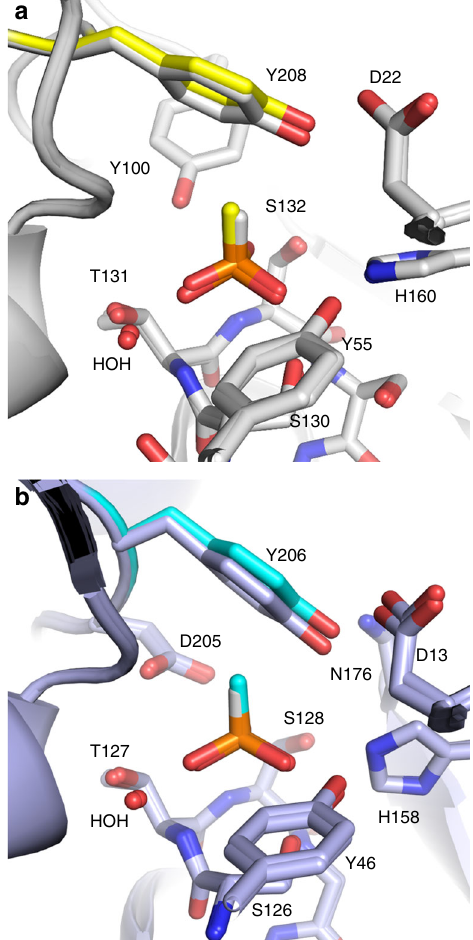
Fig. 3 A comparison of phosphite and methylphosphonate binding in Te_PtxB and Pm_PhnD. a Superposition of the complexes of Te_PtxB (grey) with phosphite (white hydrogen) and methylphosphonate (MPn; yellow methyl) showing that the residues around the binding pocket are in consistent positions in each structure apart from the capping tyrosine which moves by ~0.5 Å in the MPn complex (Y208, yellow) in response to the larger van der Waals radii of the methyl group of the ligand. b Superposition of the phosphite (white hydrogen) and MPn (cyan methyl) complexes with Pm_PhnD (blue) showing a similar movement of